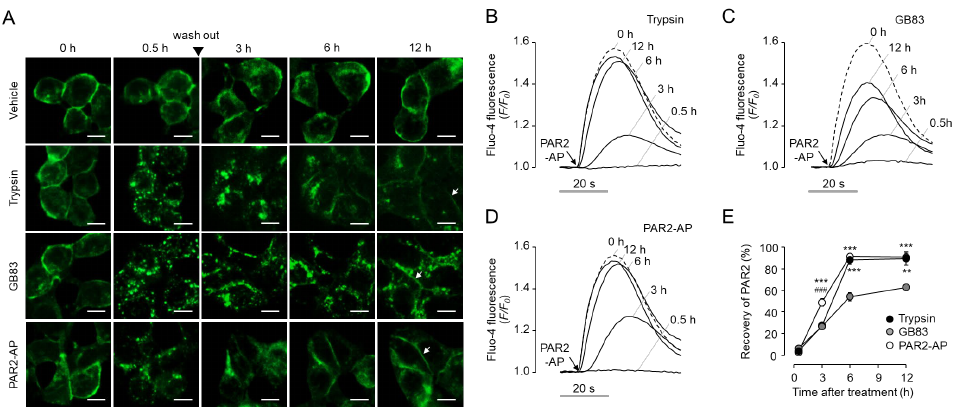
Figure 8. GB83 induced prolonged PAR2 desensitization and slow recovery of PAR2 in HT-29 cells. ( A ) Effect of trypsin, GB83, and PAR2-AP on cellular localization of EGFP-tagged PAR2 were observed at the indicated time points. Cells were treated with trypsin (30 U/mL), GB83 (30 µM) or PAR2-AP (30 µM) for 30 min, washed 3 times with PBS, and then replaced with culture medium. ( B – D ) Effect of trypsin, GB83, and PAR2-AP on functional recovery of PAR2. HT-29 cells were treated with trypsin (30 U/mL), GB83 (30 µM), or PAR2-AP (30 µM) for 30 min, washed 3 times with PBS, and then replaced with culture medium. PAR2-AP-mediated increases in intracellular calcium levels were measured at the indicated time points after wash out. ( E ) Summary of functional recov- ery of PAR2 (mean ± S.E., n = 5). Statistical significance of differences was assessed by one-way